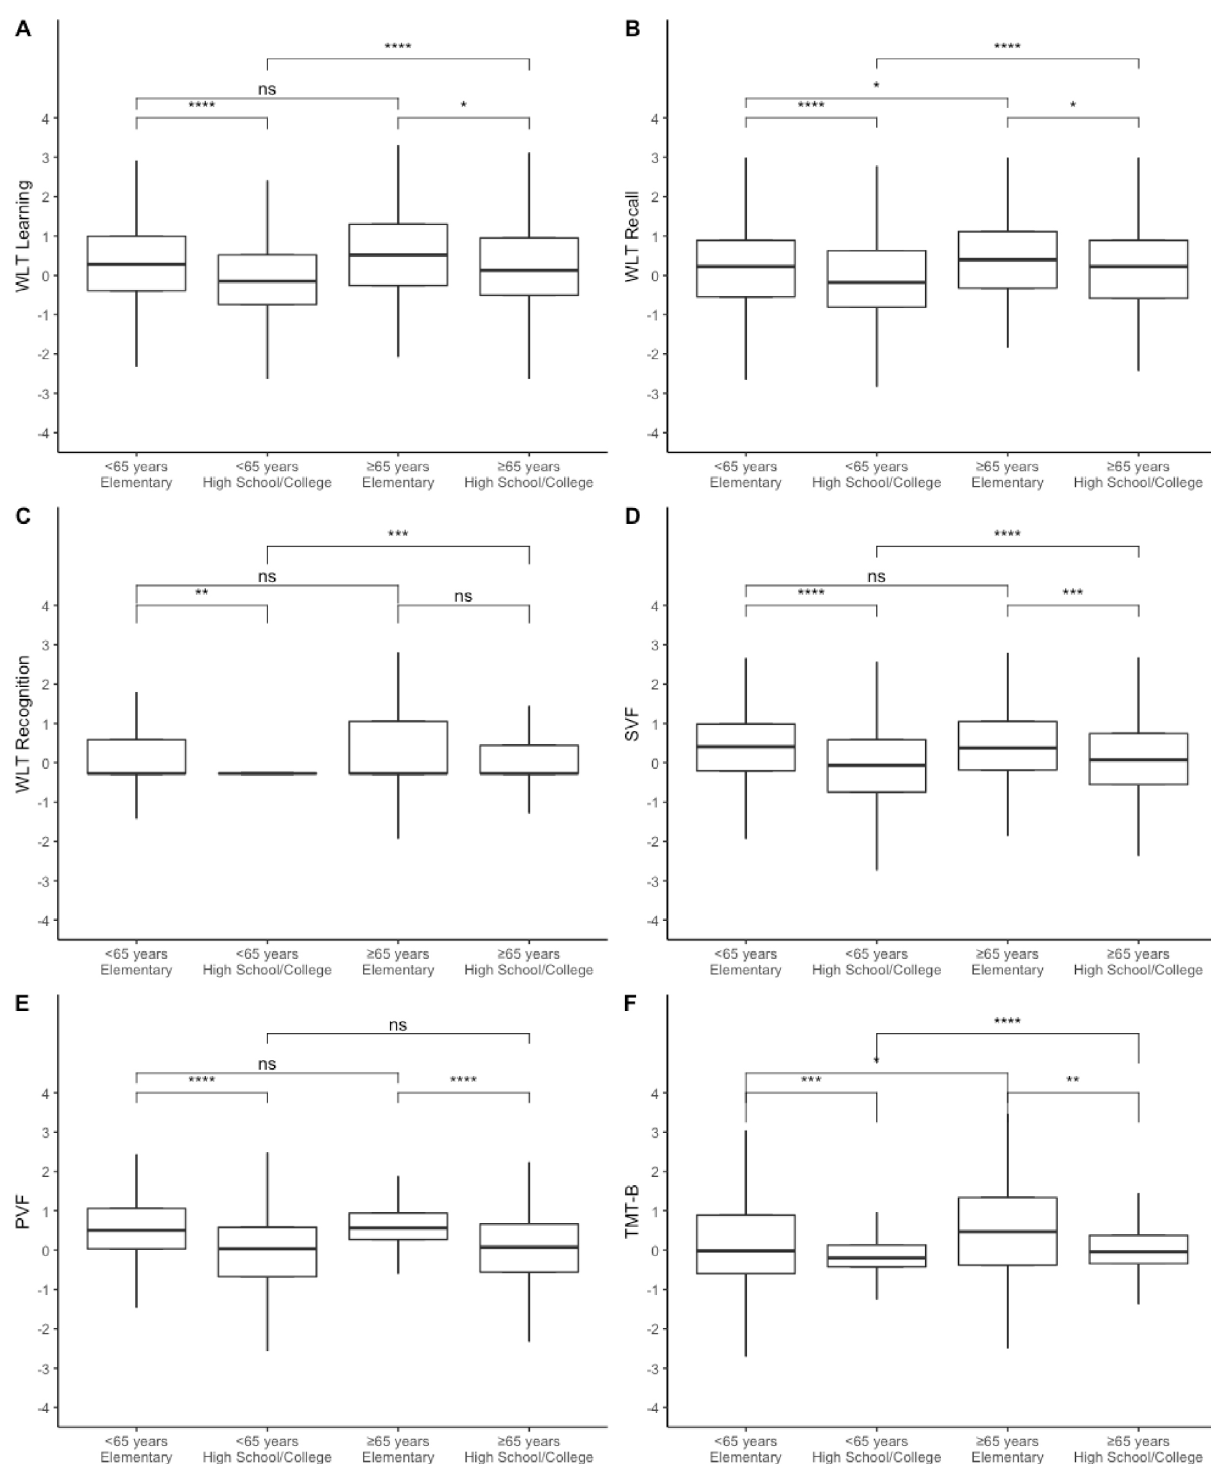
Figure 2. Retest effects boxplot by age (<65 years and 65 years or older) and education (elementary or high school and college or more) and groups comparisons (corrected for multiple comparisons). (A) WLT Learning: Word Learning Test – Learning trial. (B) WLT Recall: Word Learning Test – Recall Trial. (C) WLT Recognition: Word Learning Test – Recognition Trial. (D) SVF: semantic verbal fluency. (E) PVF: phonemic verbal fluency. (F) TMT-B: Trail Making Test Part B. Whiskers represent the standard deviation. ns: p>0.05, *p ≤ 0.05, **p ≤ 0.01, ***p ≤ 0.001, ****p ≤